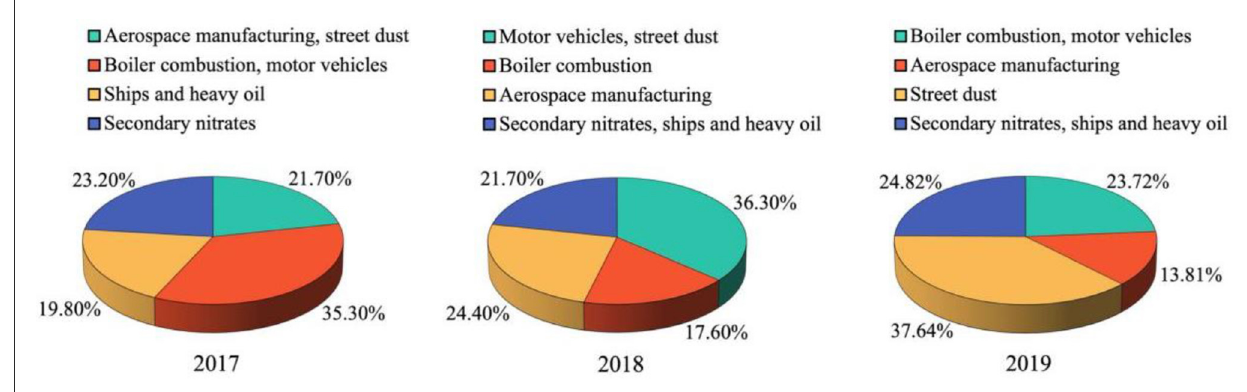
FIGURE3 Source contributions to PM 2.5 -bound metals from 2017 to 2019.